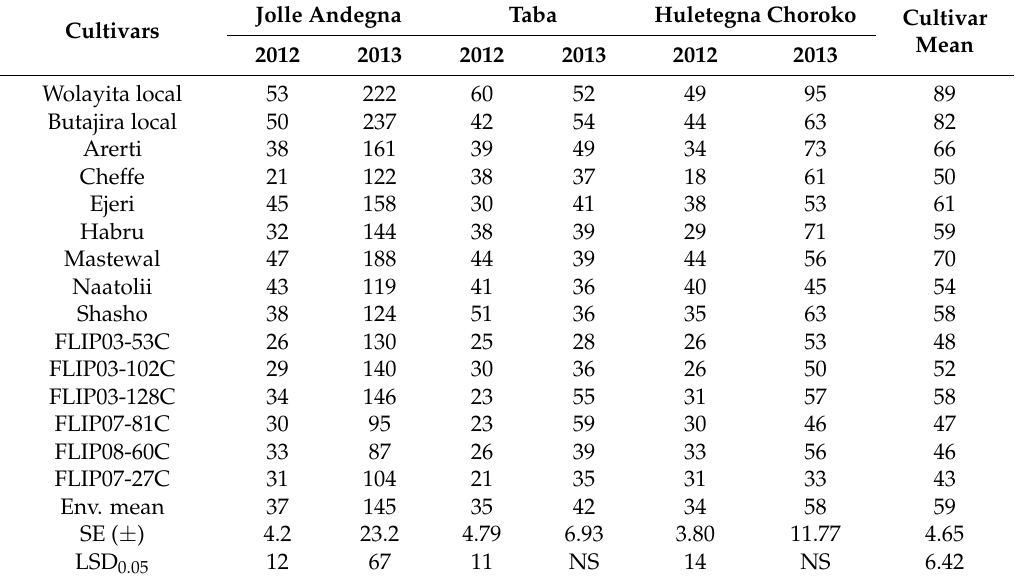
Table 4. Number of pods plant − 1 of 15 chickpea cultivars and breeding lines tested under zinc fertilized soil across three locations in southern Ethiopia during the 2012 and 2013 growing